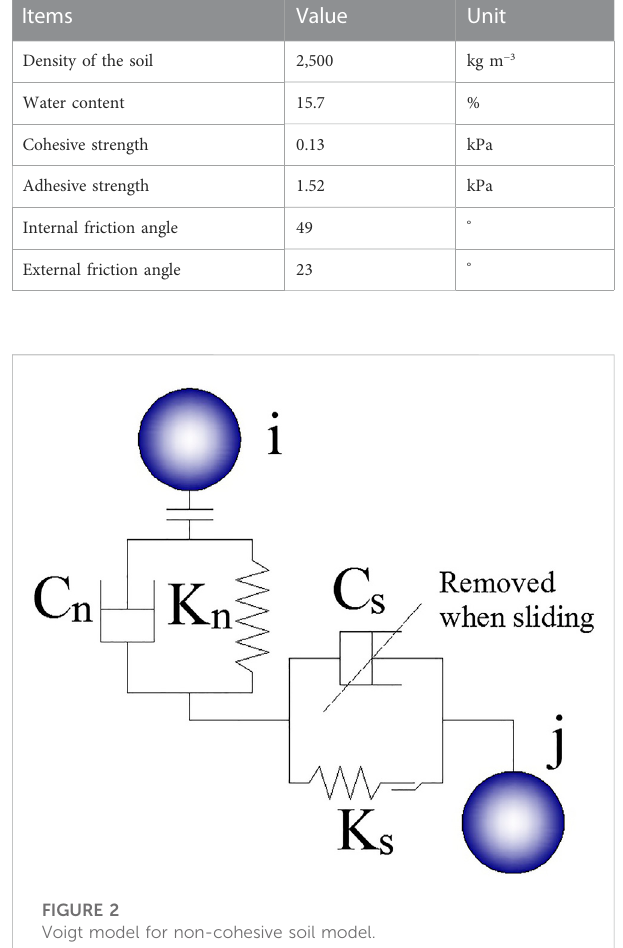
FIGURE 2 Voigt model for non-cohesive soil model.